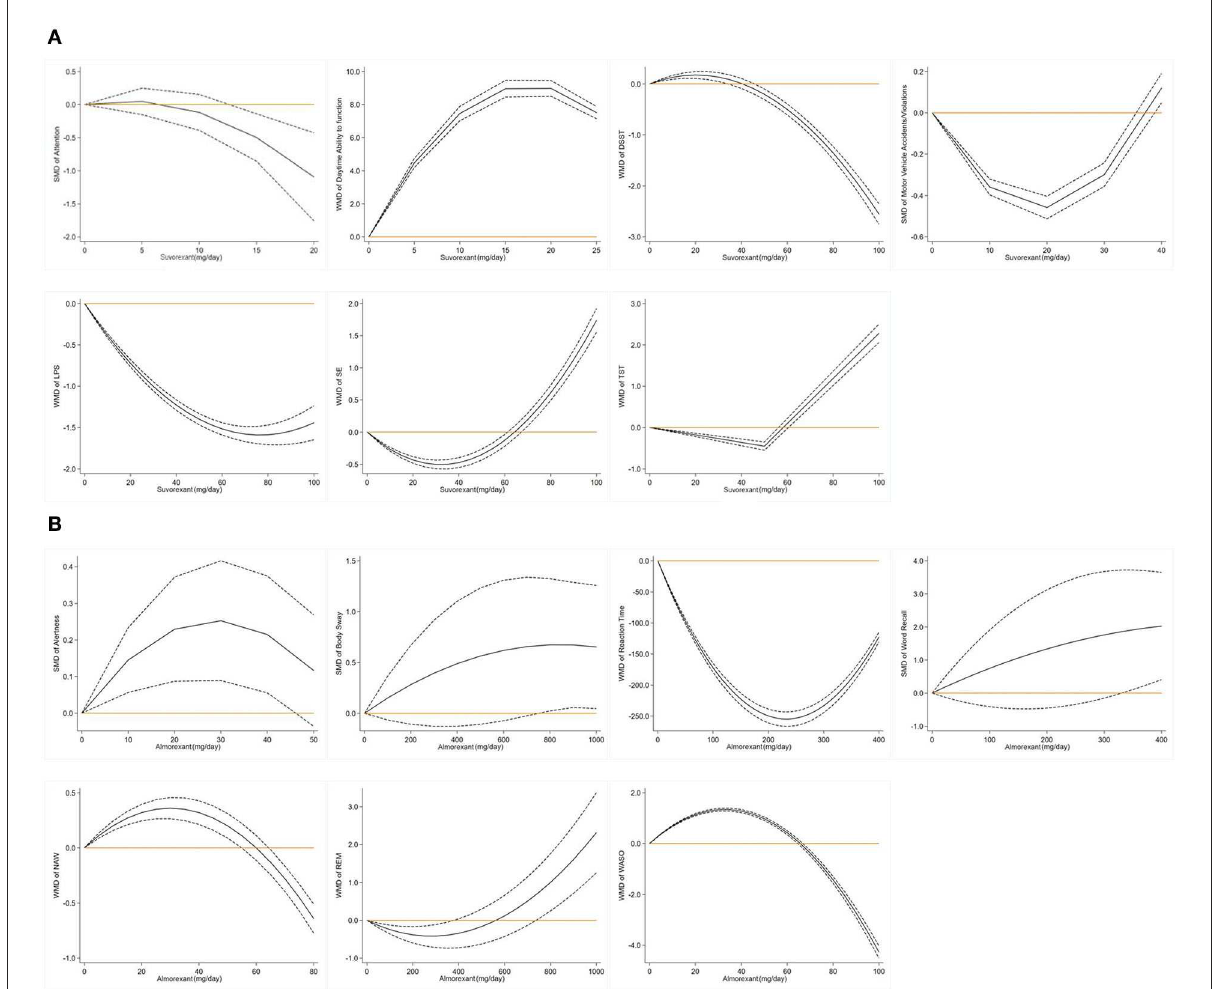
FIGURE4 (A) Suvorexant is the first approved drug under DORA. According to the dose-response non-linear curve, at 20mg, the subjects scored the highest on the DSST scale, and the incidence of motor vehicle driving violations/accidents was the lowest. At doses below 20mg, the subjects had better information processing, attention, and psychomotor abilities. The diurnal function of the subjects in the suvorexant group decreased significantly after taking a dose of more than 20mg. It was concluded that the maximum dose of suvorexant should not be more than 20mg, which was consistent with the recommended doses of 5, 10, 15, and 20mg in the guidelines. The sleep result seems to have little relationship with the dose. With the increase in dose, LPS decreases, and TST prolongs. SE is lower when it is < 30mg, then SE increases. (B) In the Almorexant group, the subjects’ alertness scores were higher at 10mg to 30mg and reached the highest alertness at 30mg, while when the dose was > 30mg, the alertness gradually decreased. In addition, the reaction time decreased with the increase in dose. The dose did not affect the word memory score and body swing amplitude. NAW and WASO showed an upward trend before 30mg and reached the highest point at 30mg.